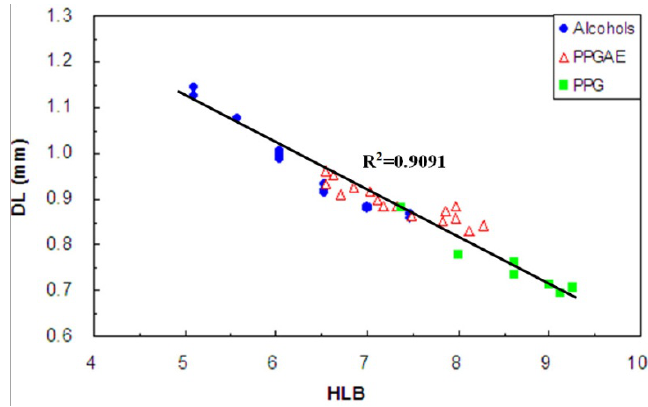
Figure 13. Minimum bubble size D regression model, Equation